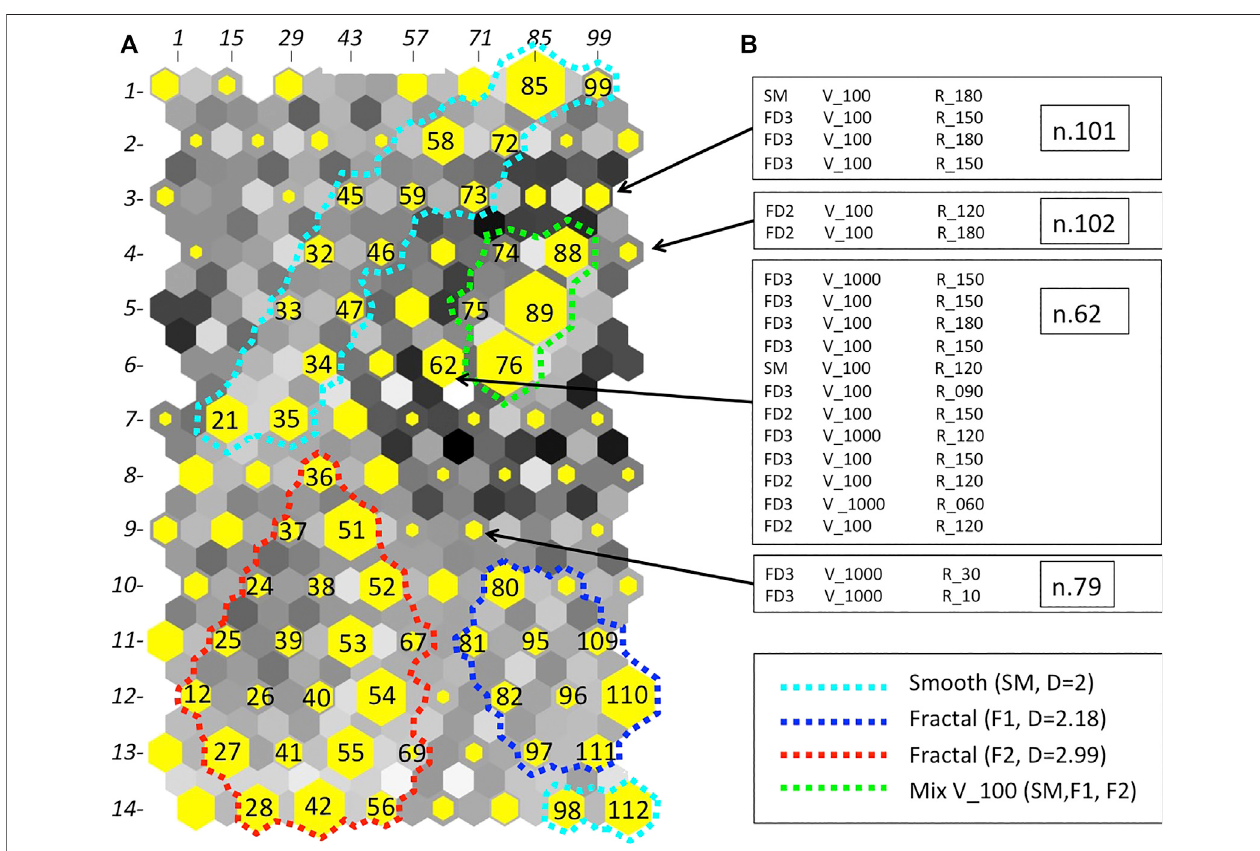
FIGURE7 |(A) The SOM Map with14 × 8 (cid:2) 112 nodes. Not-empty nodes are shown as yellow hexagons and their size representsthe data density. The numbers on the outside of the map indicate the numbering of the nodes that is also reported in some signi fi cant nodes. The gray hexagons interposed between the yellow ones indicate the Euclidean distance between the nodes according to a gray scale. Cluster 1 (cyan), Cluster 2 (blue), Cluster 3 (red) and Cluster 4 (green) are highlighted by dottedoutlines.Ontheright (B) thecompositionsofnodesn.62,n.79,n.101and n.102areshown.ThelabelsSM, F1andF2indicateSM(smooth), F1(FD (cid:2) 2.18) and F2(FD (cid:2) 2.99)conduitroughness,respectively.Thenumber preceded byVindicates theviscosityinPa sandthenumberprecededbyRindicatesthegas fl owrate in 10 − 3